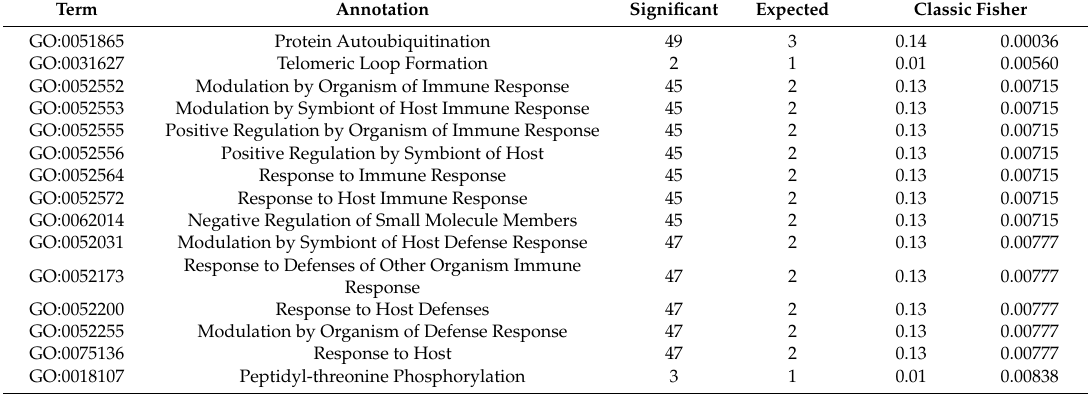
Table 1. The 15 enriched Gene Ontology (GO) terms of genes in the green module according to classic Fisher to order.